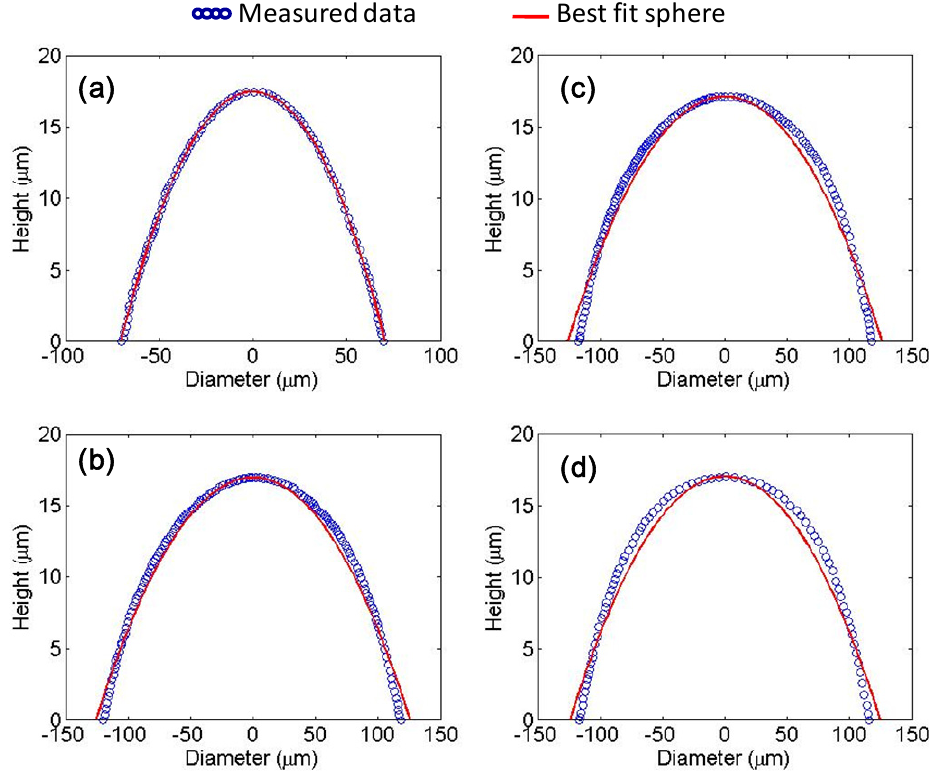
Figure 5. Lens profile of: (a) circular lens quadratic grid (d = 135 μ m), (b) circular lens hexagonal grid (d = 235 μ m), (c) hexagonal lens (d = 235 μ m), and (d ) square lens (d = 235 μ m) by probe-type surface analyzer. The circles show measured points and solid lines are best fit